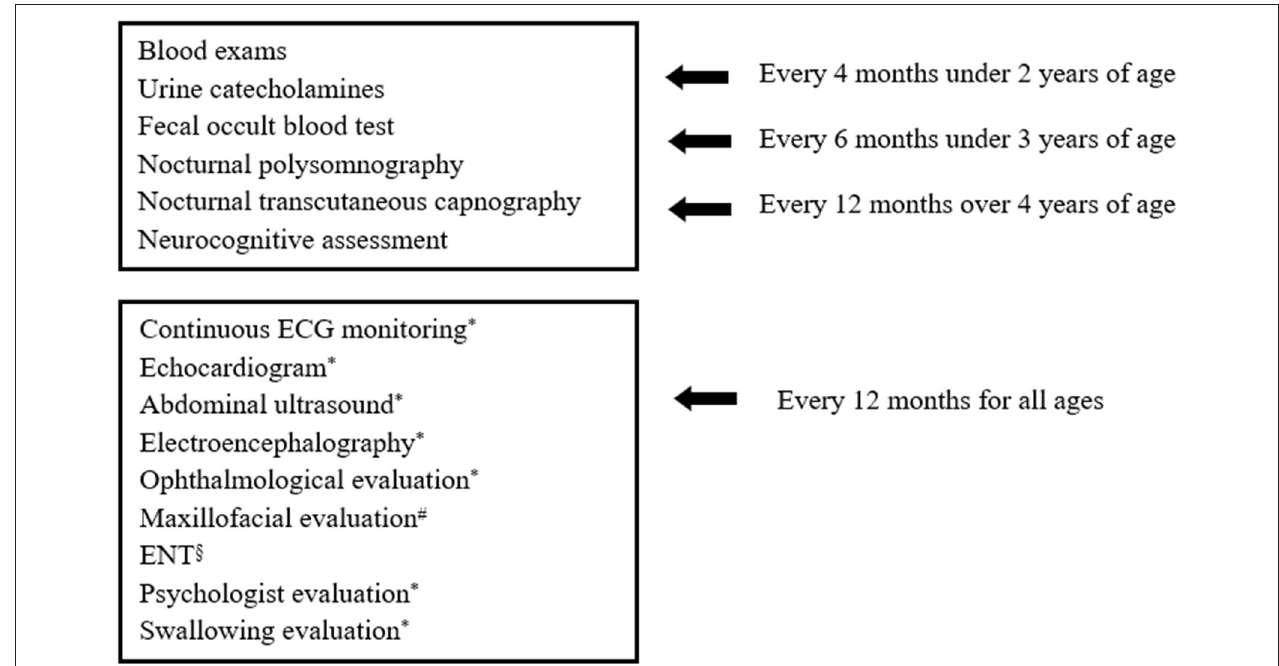
FIGURE 1 | Investigations included in Bambino Gesù Children’s Hospital follow-up program for patients with CCHS. # in case of NIV. § in case of tracheostomy. *evaluations carried out annually or as